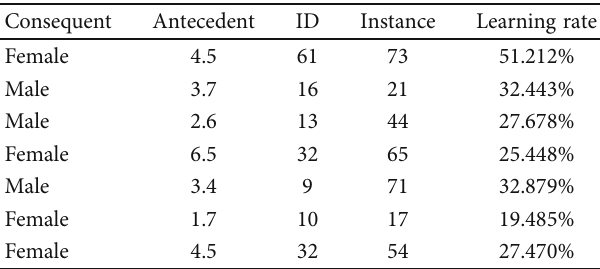
Table 1: Important associative